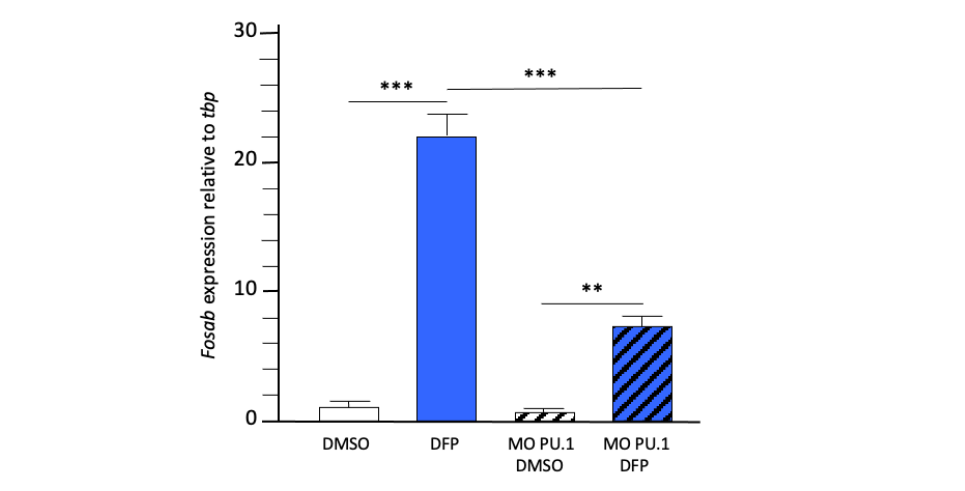
Figure 7. Microglial depletion markedly reduced DFP-induced neuronal hyperactivation. Ex- pression levels of fosab RNAs relative to that of reference tbp transcripts, from control larvae and pU.1 morphants exposed for 6 h to either 1% DMSO (DMSO) or 15 µ M DFP (DFP) (in each condition, N = 7–8 samples, n = 7 larvae/sample). Error bars on all graphs represent the standard error of the mean (SEM). Statistics: **, p < 0.01; ***, p <